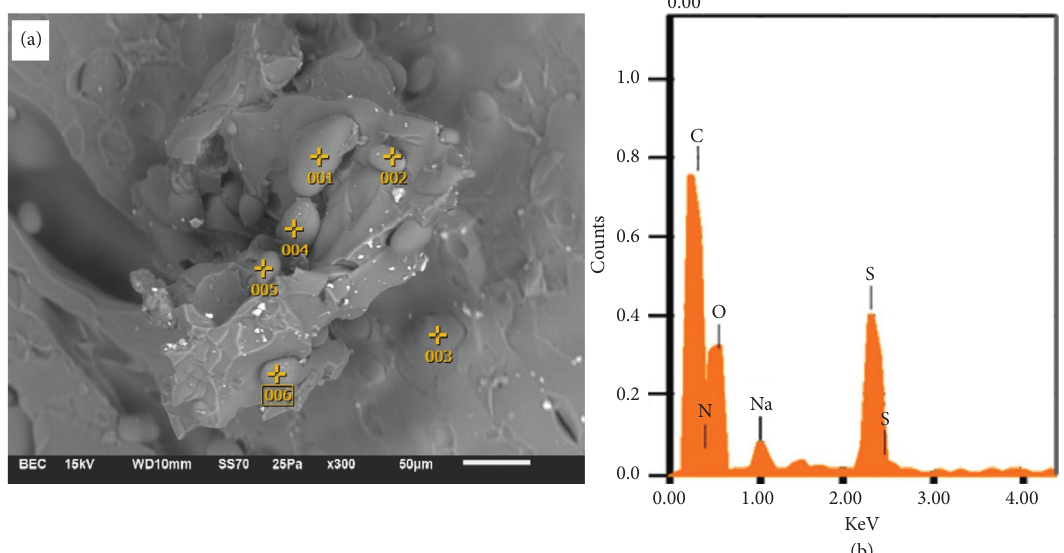
Figure 8: EDX spectrogram of PAAm/starch 50/50 hydrogel loaded with amoxicillin: (a) SEM image; (b) EDX spectrogram.